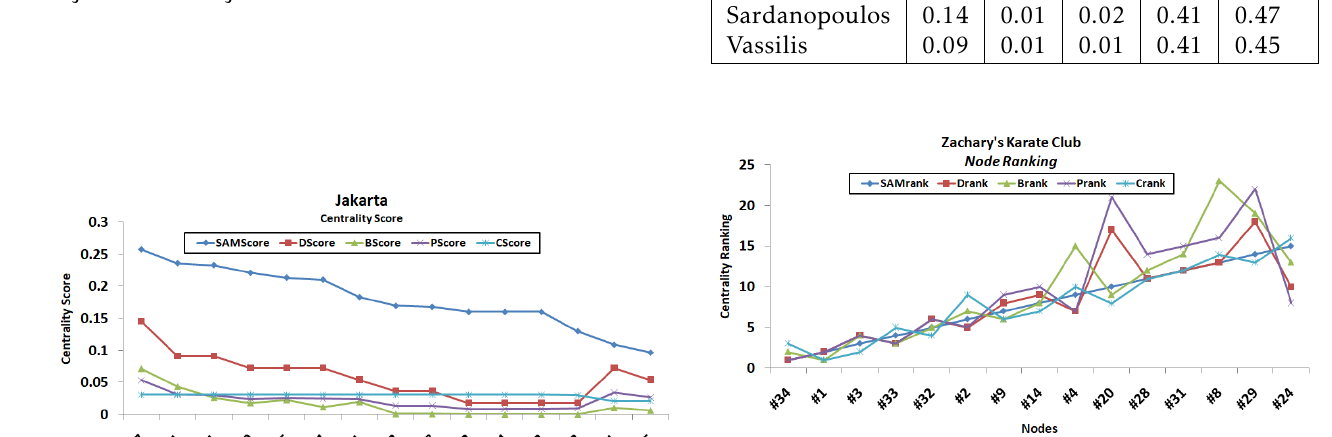
Figure 8. Ranking of top 15 nodes from Jakarta dataset, sorted by SAM centrality